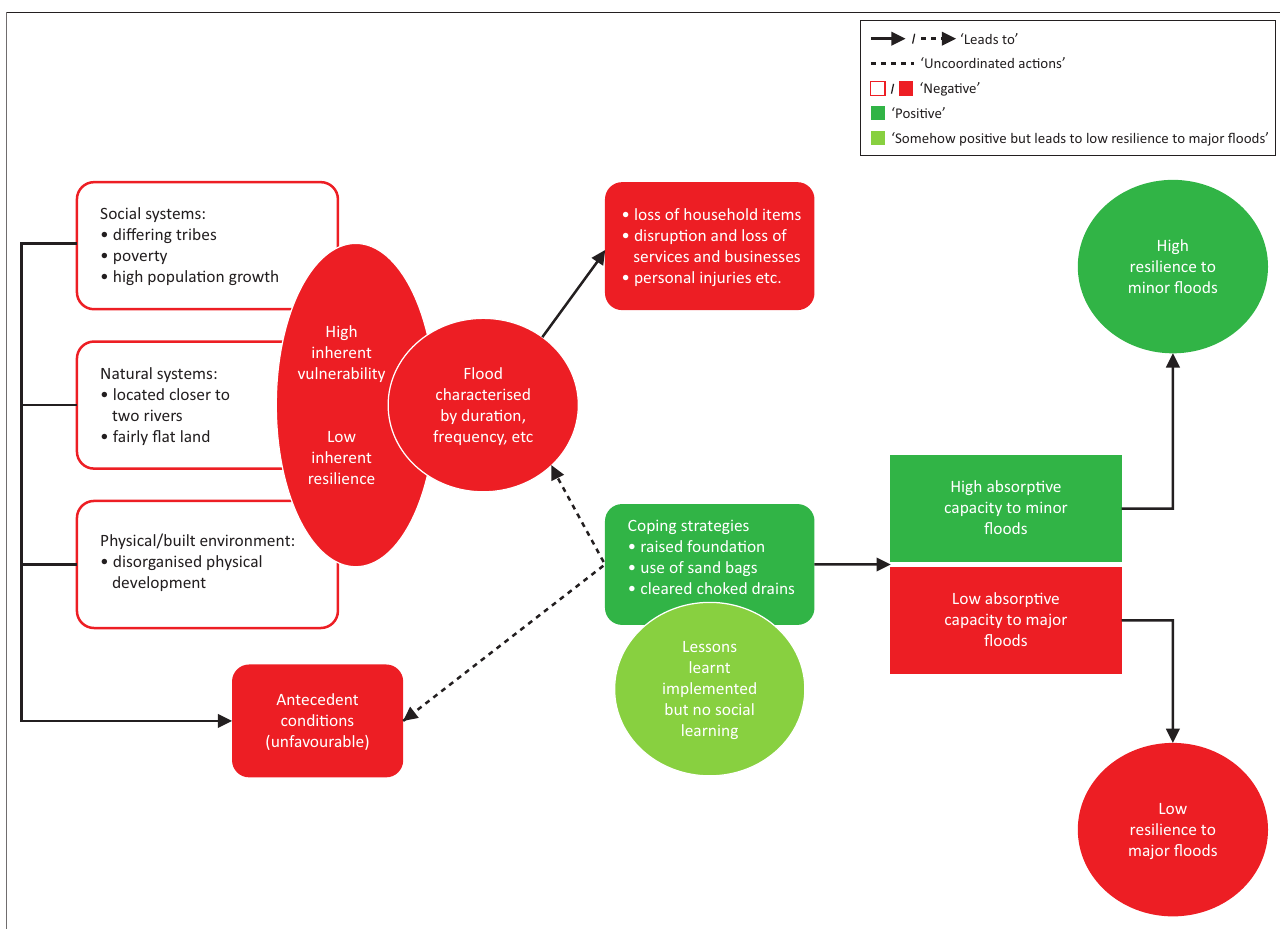
FIGURE 6: Conceptualised disaster resilience of place model for